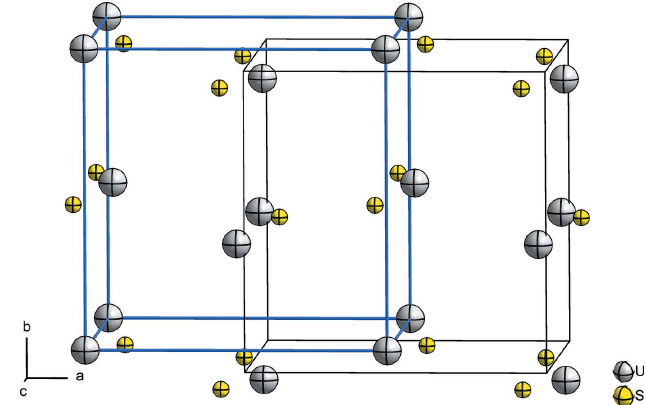
Figure 2 Packing of the U and S atoms in the crystal structure of (SCl 3 )[UCl 6 ], showing a distorted NaCl-type arrangement. The unit cell drawn in black can be shifted to the one highlighted in blue to make the relation more easily visible. The idealized blue unit cell shows the deviation of U atoms from F -centering as well as the deviation of the (SCl 3 ) + entities (Cl atoms not shown) from the octahedral